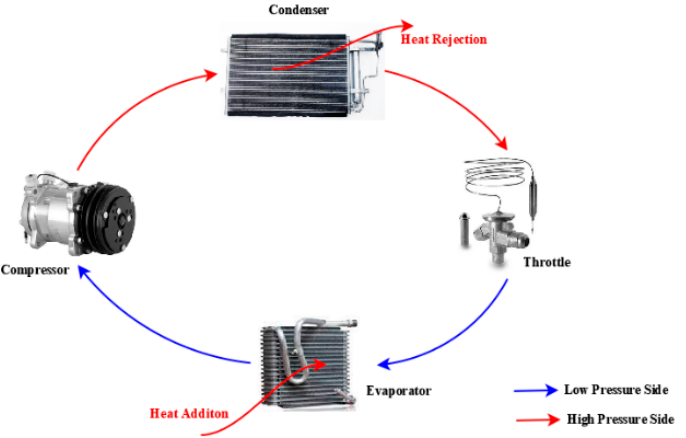
Figure 2. Vapor-compression refrigeration system.